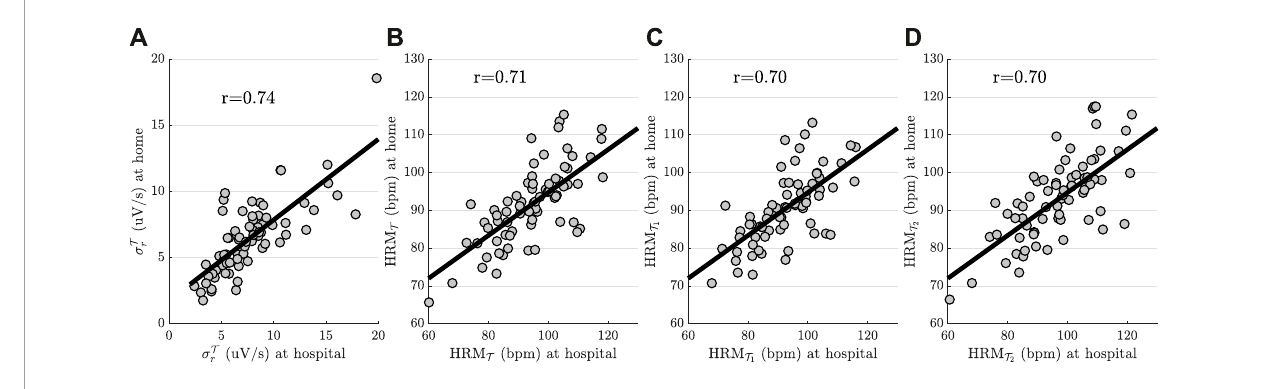
FIGURE 4 Scatter plots of the most significant ANS parameters derived during 2MWT performed at hospital and at home. (A) σ T r , (B) HRM T , (C) HRM T HRM T 2